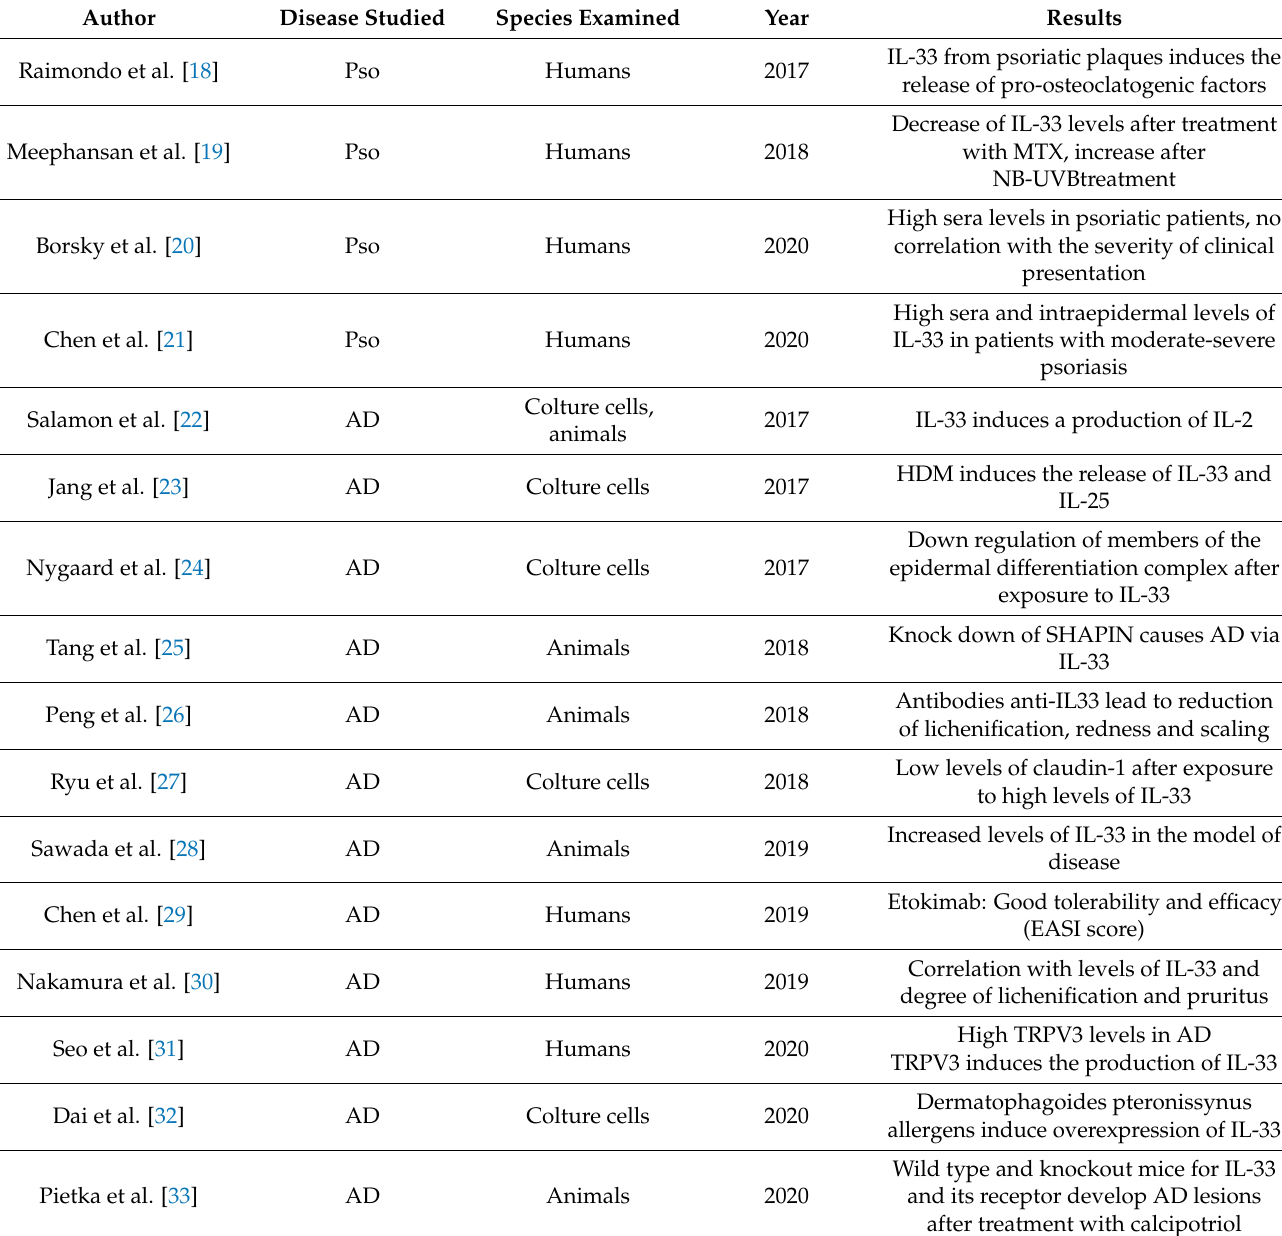
Table 2. Interleukin 33 and skin. Results are inclusive of both psoriasis and atopic dermatitis. The results are ordered by year and a quick recap was produced by author’s name, disease, specimens and